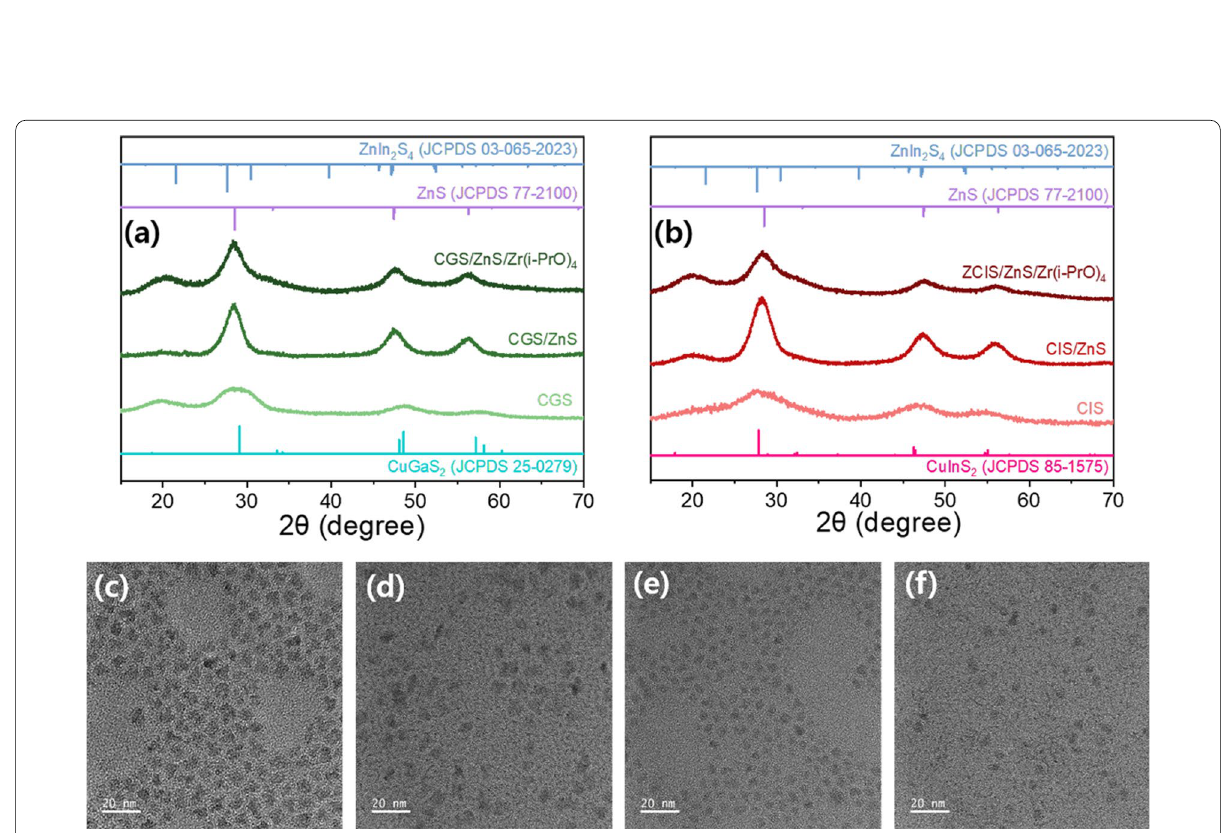
Fig. 2 XRD patterns of a green QDs of CGS, CGS/ZnS and CGS/ZnS/Zr(i-PrO) 4 and b red QDs of CIS, CIS/ZnS and CIS/ZnS/Zr(i-PrO) 4 . TEM images of green QDs of: c CGS/ZnS and d